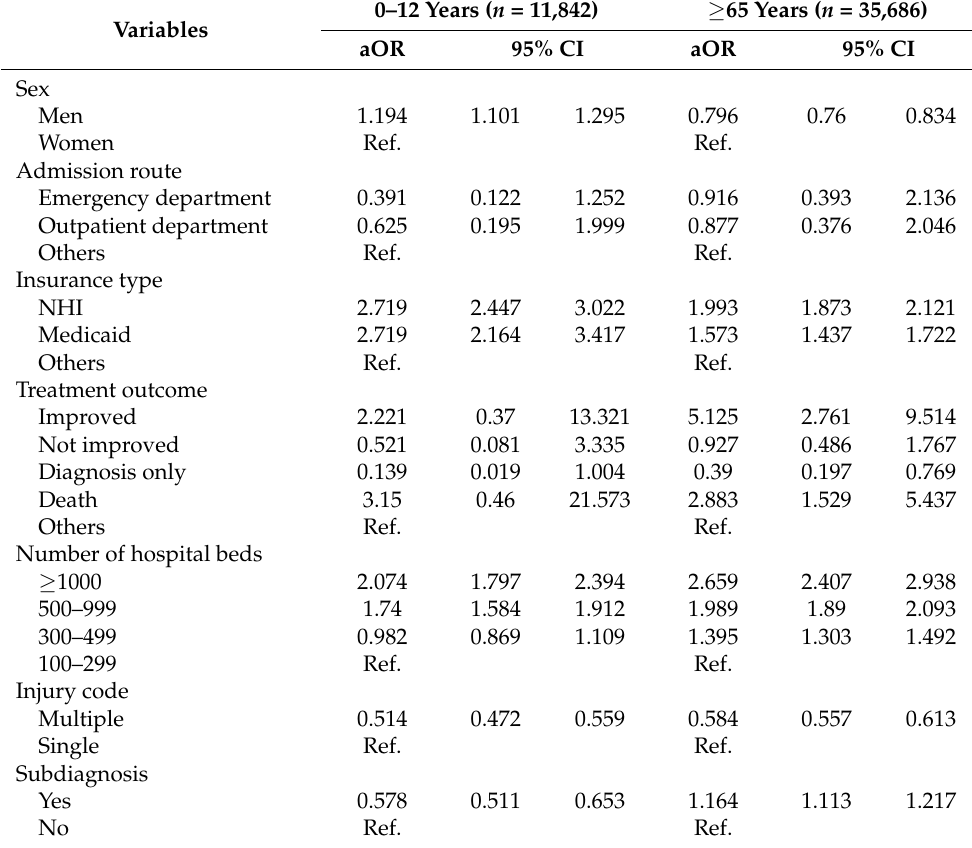
Table 5. Factors associated with surgery in children and elderly patients with